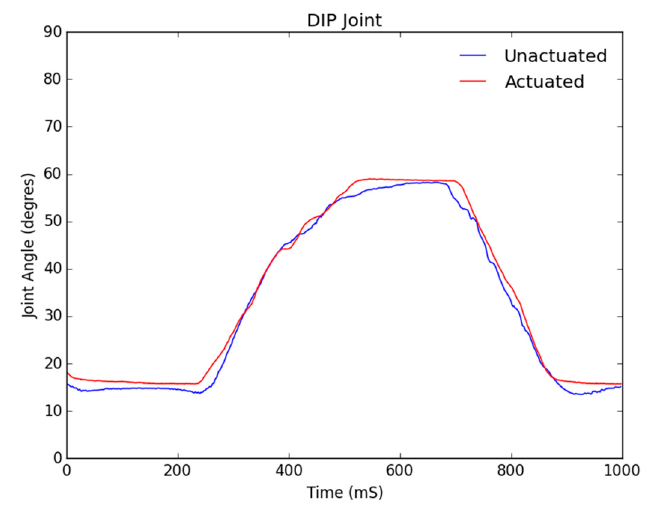
Figure 9. Motion analysis data for the distal interphalangeal (DIP) joint.